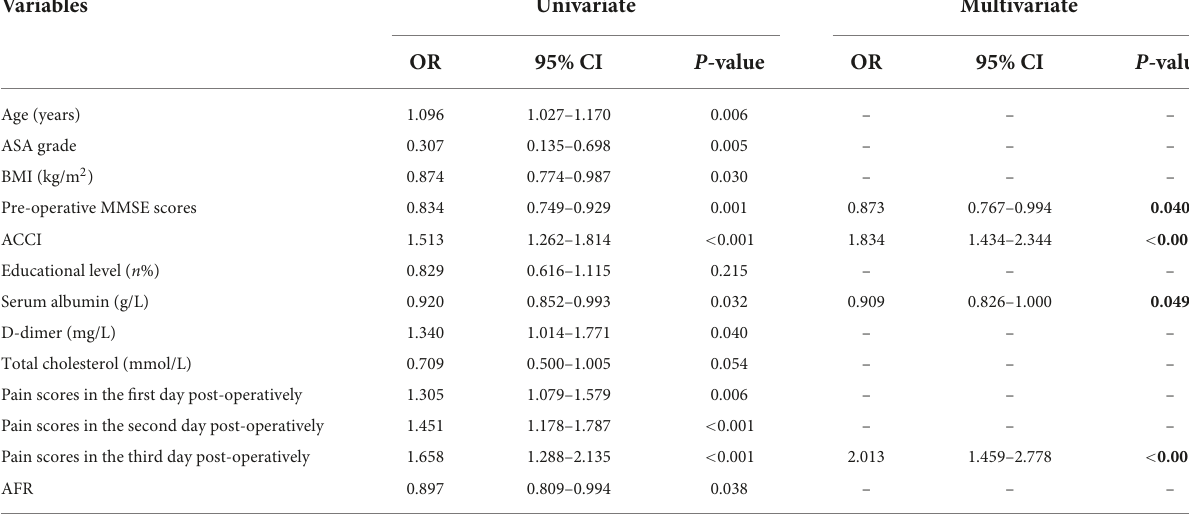
TABLE 3 Univariate and multivariate logistic regression analyses of clinical associated risk factors for post-operative delirium (POD).